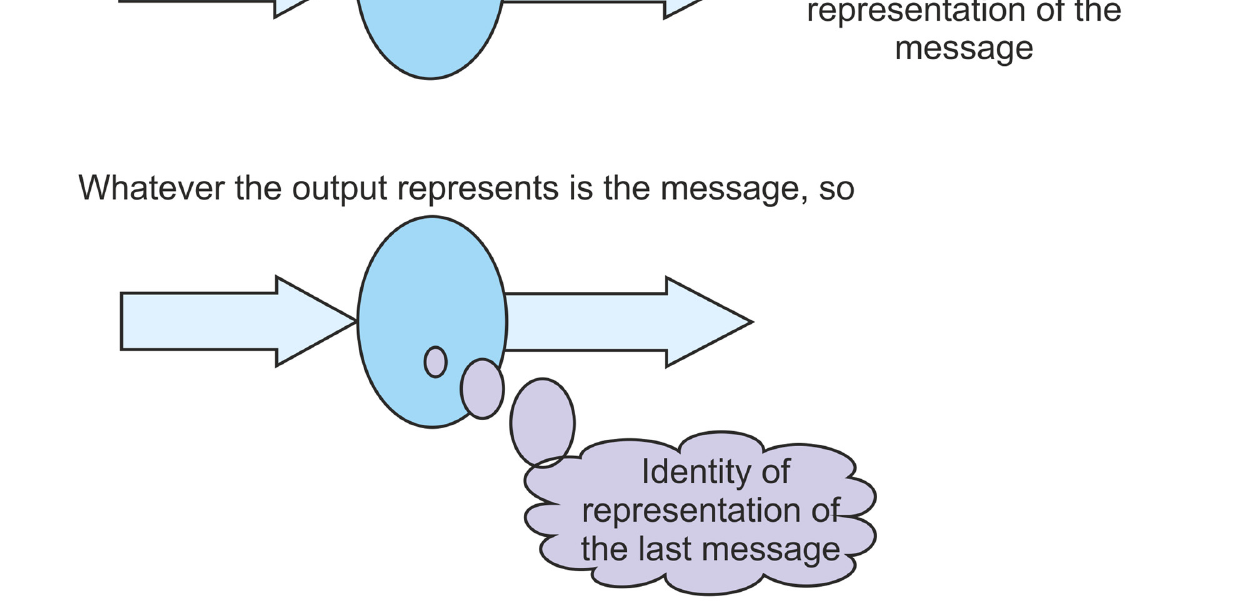
FIGURE 4 | A key component of the theory presented is that in a settled fixed-point attractor state a network is able to identify its own representations fed back to it as representations. This figure aims to clarify the argument for why this is the case. It shows that in an attractor state, as information is cycled through the network, the network is able to identify its fed back input on each pass as a representation of the previous message.